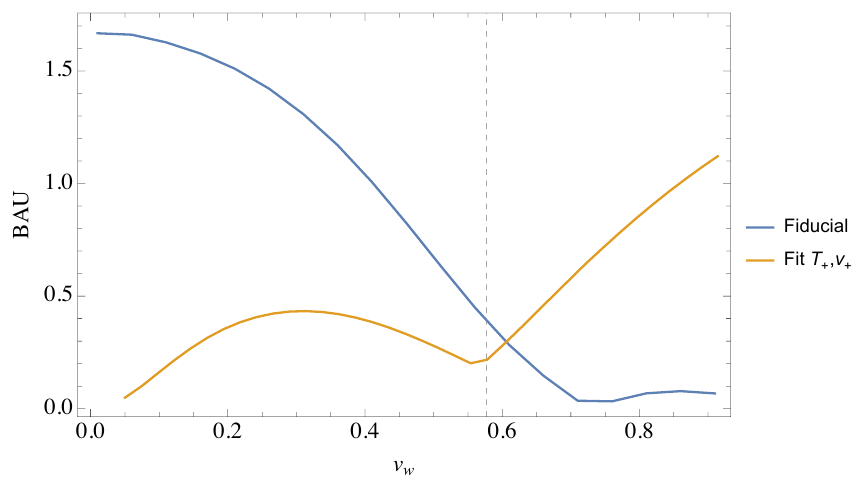
Figure 11 . Baryon yield as a function of velocity for the fiducial point (7.11) and using the fits of eqs. (7.12) and